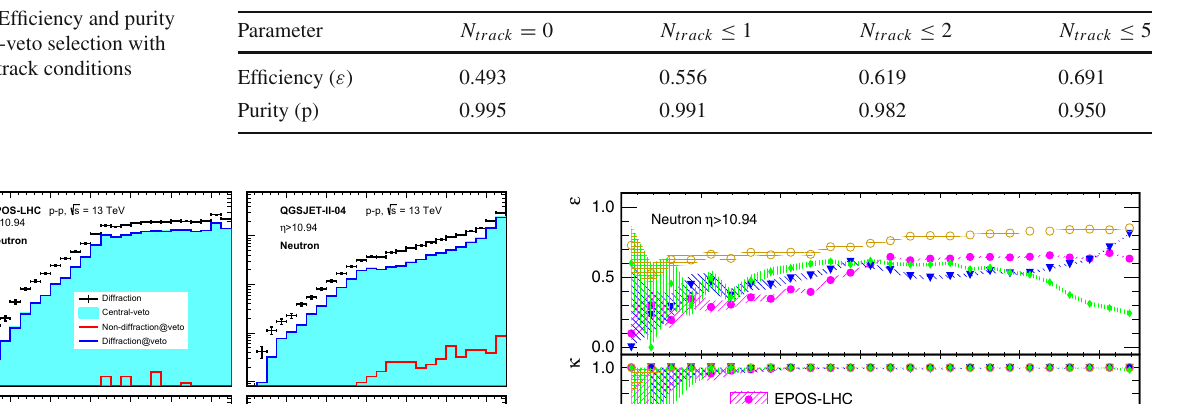
has almost 100% SD detection efficiency in the region of (ξ ) > − 5 but decreases rapidly to 0 at log log x 10 [35]. Therefore, the common experiment using central